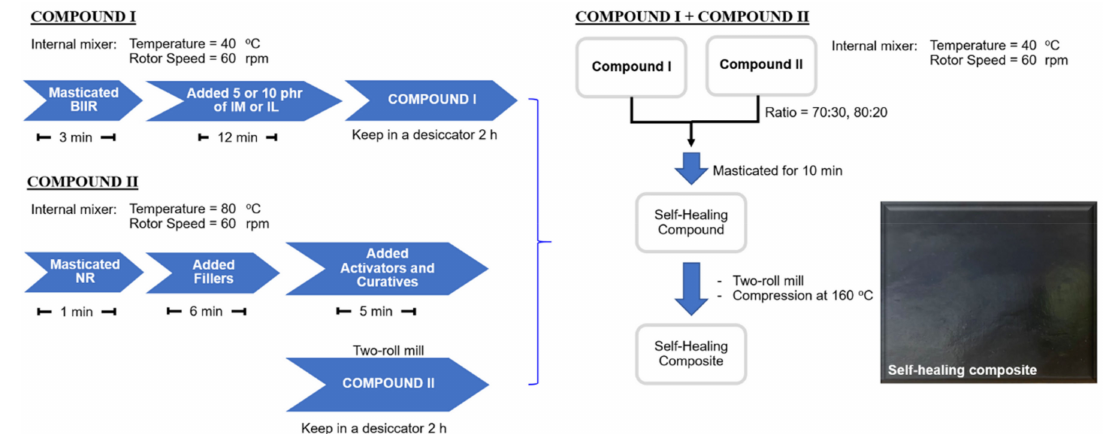
Figure 1. Preparation procedures of the bromobutyl rubber (BIIR)/ natural rubber (NR) composites with ionic liquid (IL) and butylimidazole